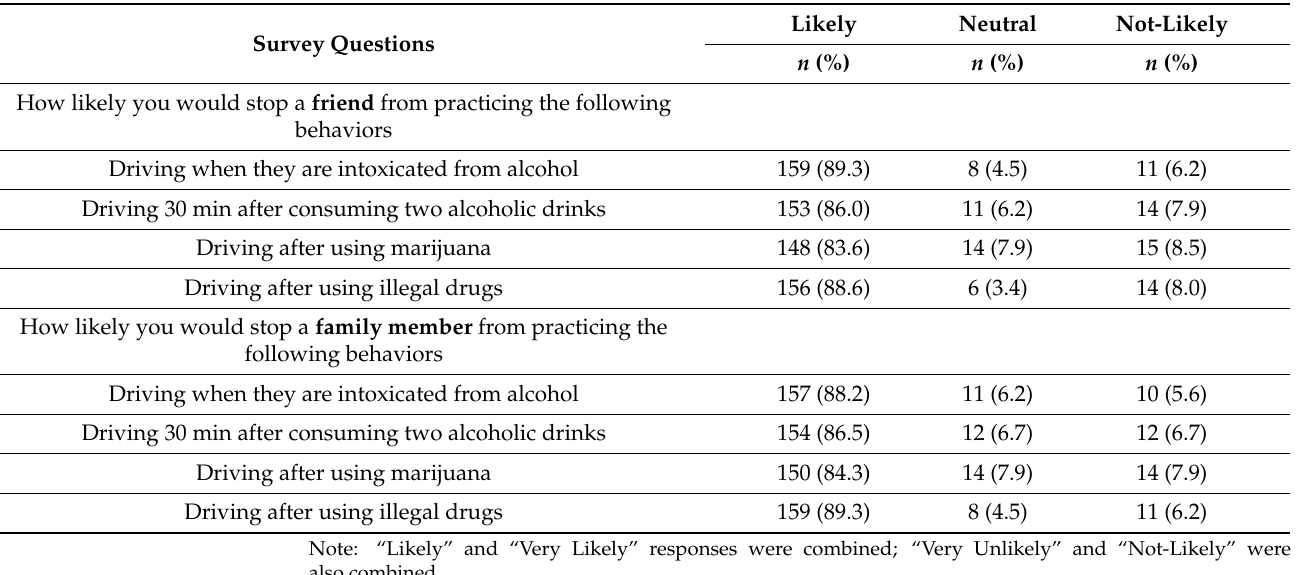
Table 4. Previous participants likelihood of stopping a friend or family member practicing unsafe driving behaviors ( n =